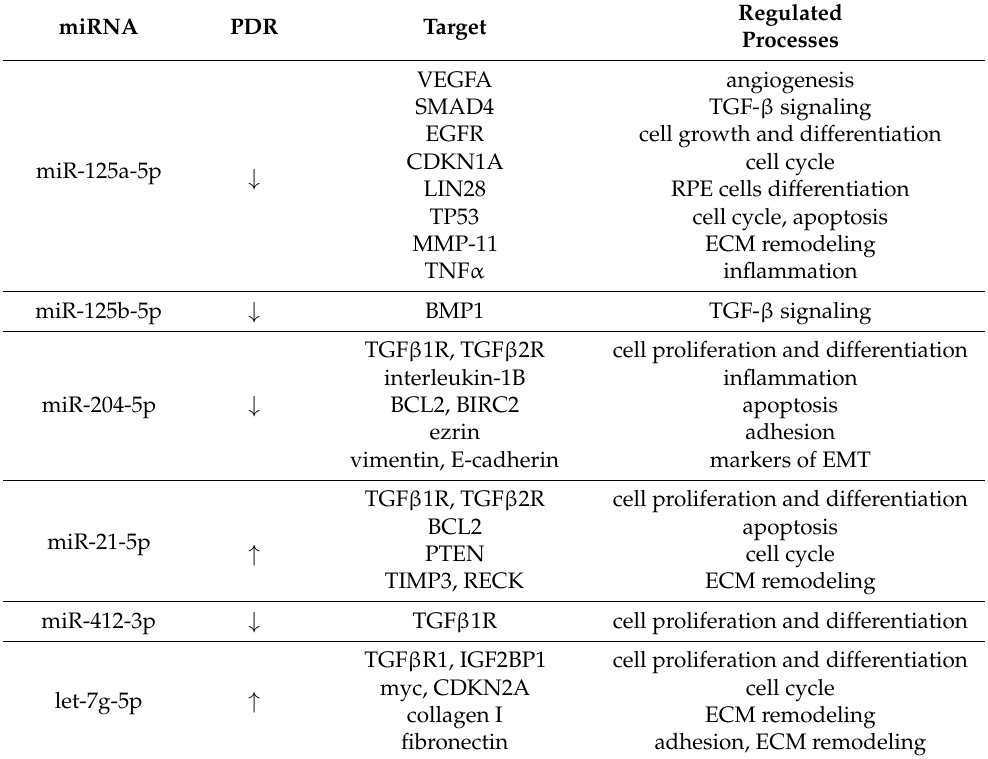
Table 2. Experimentally validated miRNA-target interactions of the top six most differentially expressed